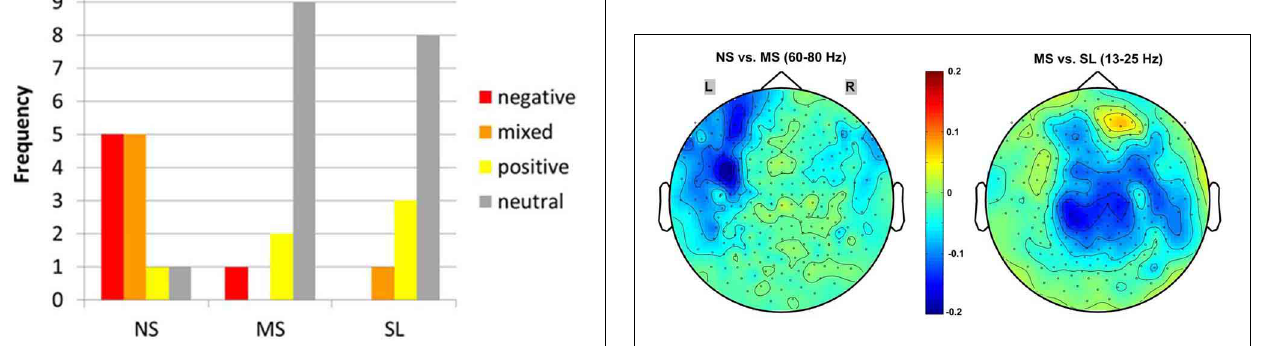
FIGURE 2 | Emotional content during NS, MS, and SL. Distribution of emotional content among participants ( x -axis) during NS, MS, and SL ( y -axis). Note the marked difference between NS and other 2 conditions regarding negative and mixed vs. neutral emotions.